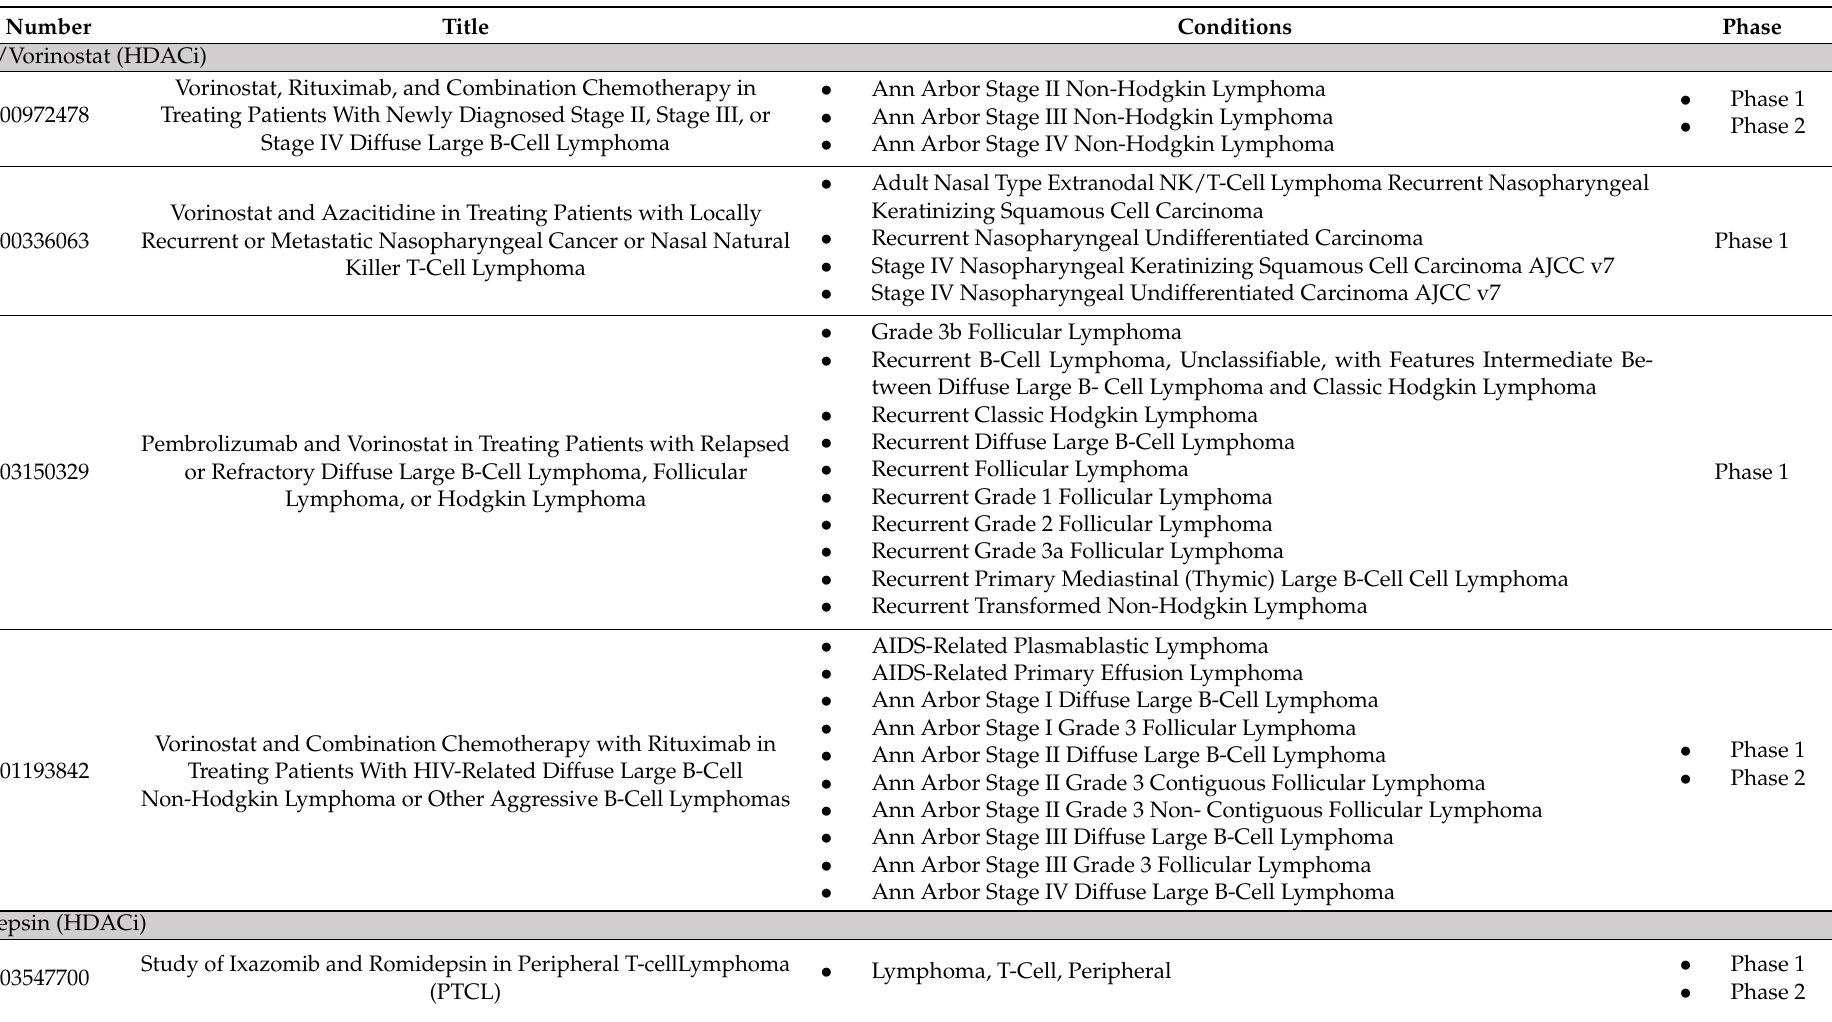
Table 3. Clinical trials of FDA-approved epigenetic drugs in lymphoproliferative